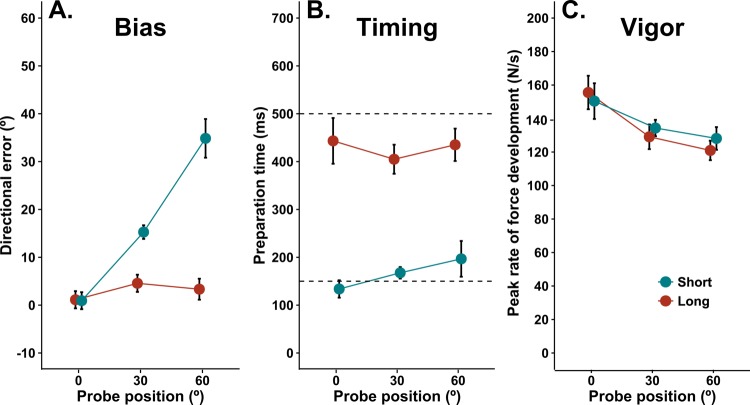
Effects of movement history in a timed response task.Effects of movement history on aiming bias (A), the time of movement initiation after target presentation (B), and movement vigor (C) for both long and short preparation time conditions in a timed response task. Plots show group mean values (±within subjects SE, see Materials and methods for details) of the median effect for each participant. Dashed lines in B indicate the time at which movement initiation was cued.10.7554/eLife.26713.004Figure 2—source data 1.Source data for plots in panels 2a, 2b, 2c.